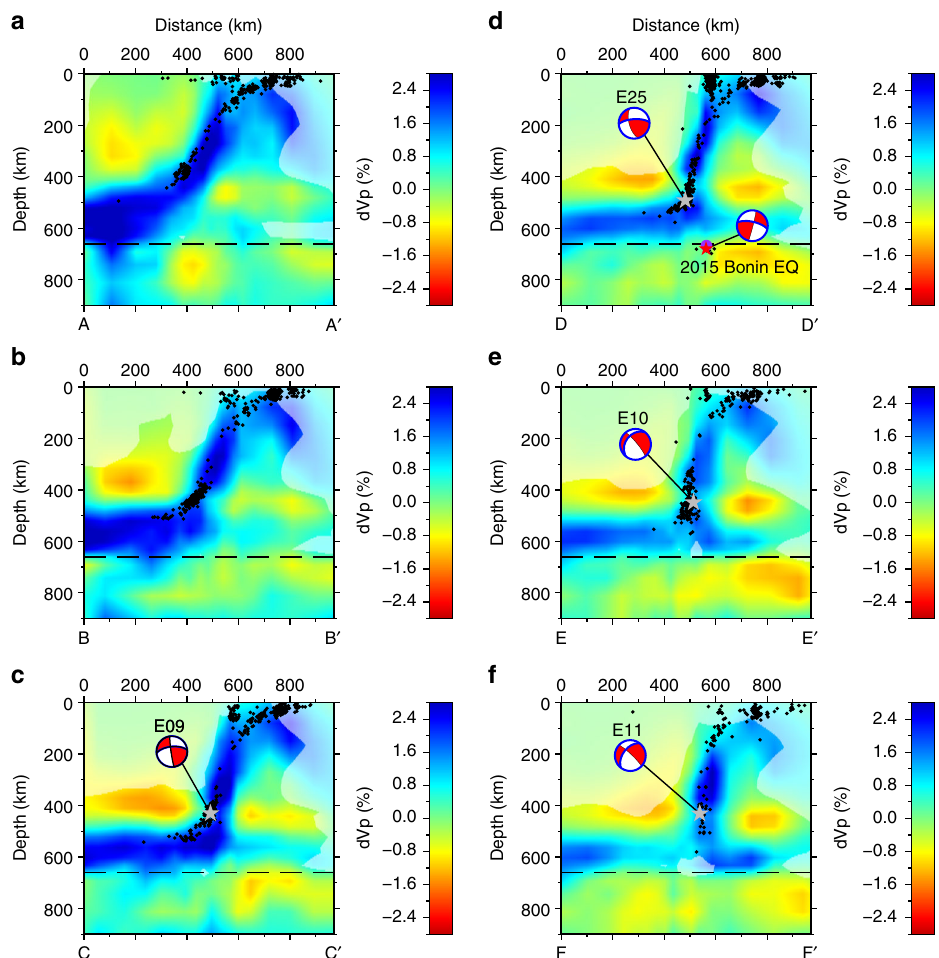
Fig. 2 Tomographic images of P-wavespeed and relocated earthquakes within the sections shown in Fig. 1. The shaded regions are associated with low model resolution, which is estimated by calculating the semblance values between the true and recovered checkerboard anomalies (see Supplementary Information). Note that in Sections d – f, the high-velocity anomaly appears to split in the mantle transition zone (MTZ). This is mainly due to the orientation of the slab tear. Sections d and e show parts of the slab on both sides of the inferred slab tear (see Figs. 1 and 3). Also shown are focal mechanisms and rupture planes for moderate-to-large earthquakes (Mw > 5.7) in the MTZ determined by directivity analysis in a previous study (Myhill and Warren 43 ), rotated into the plane of section. The EXX codes represent the catalogue IDs in that study. The rupture planes for each earthquake (Myhill and Warren 43 ; Ye et al. 29 ) are highlighted in